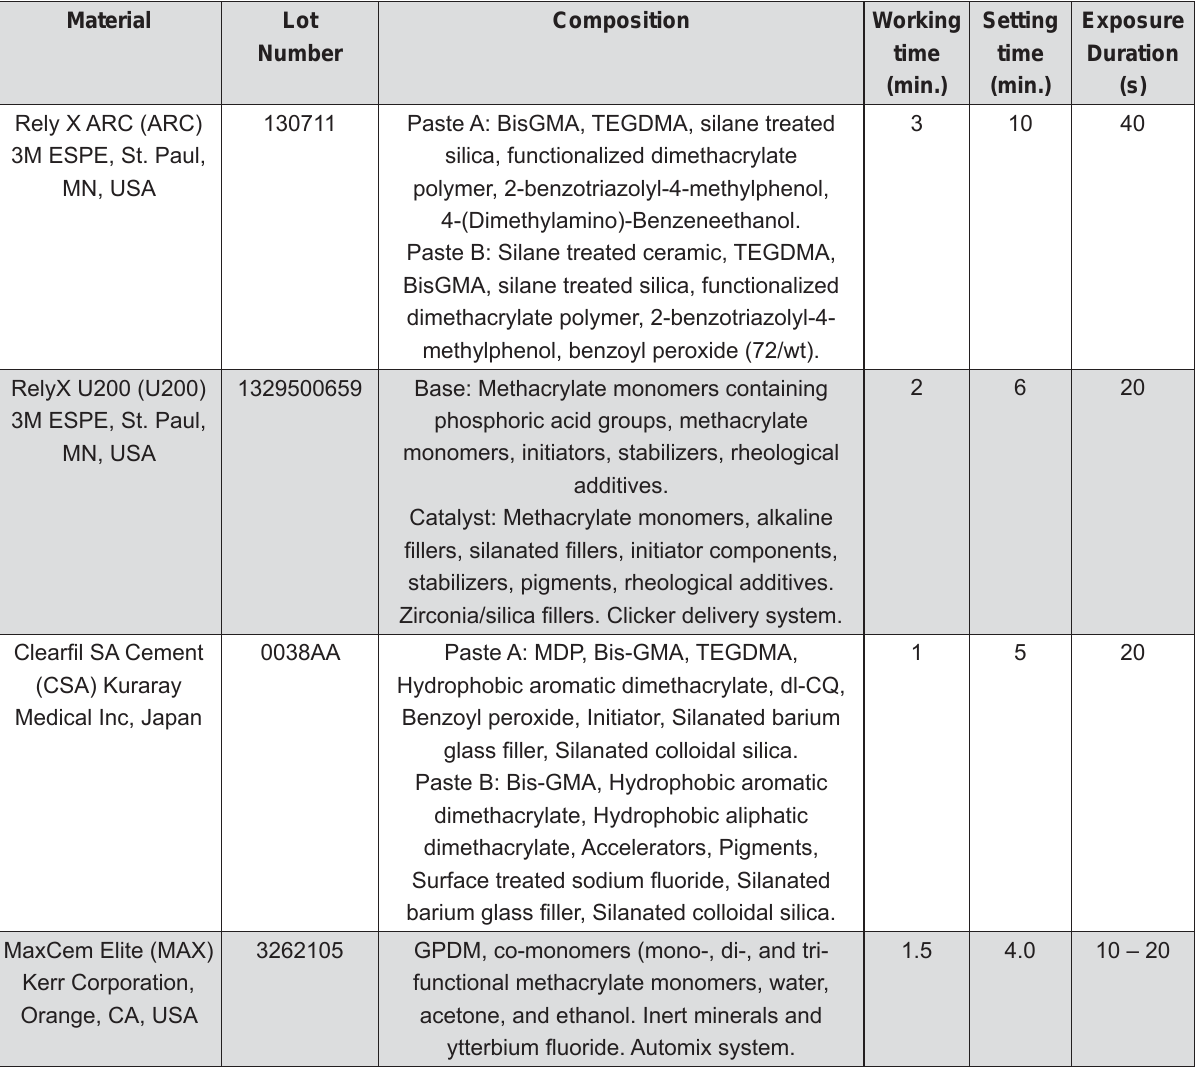
Abbreviations: Bis-GMA: bisphenol A diglycidyl ether dimethacrylate; TEGDMA: triethyleneglycoldimethacrylate; UDMA: Urethane dimethacrylate; GPDM: glycero-phosphate dimethacrylate; MDP: methacryloyloxydecyl dihydrogen phosphate; CQ: camphorquinone. All information supplied by manufacturers. Figure 1- Composition, manufacturers, and batch numbers of the cements